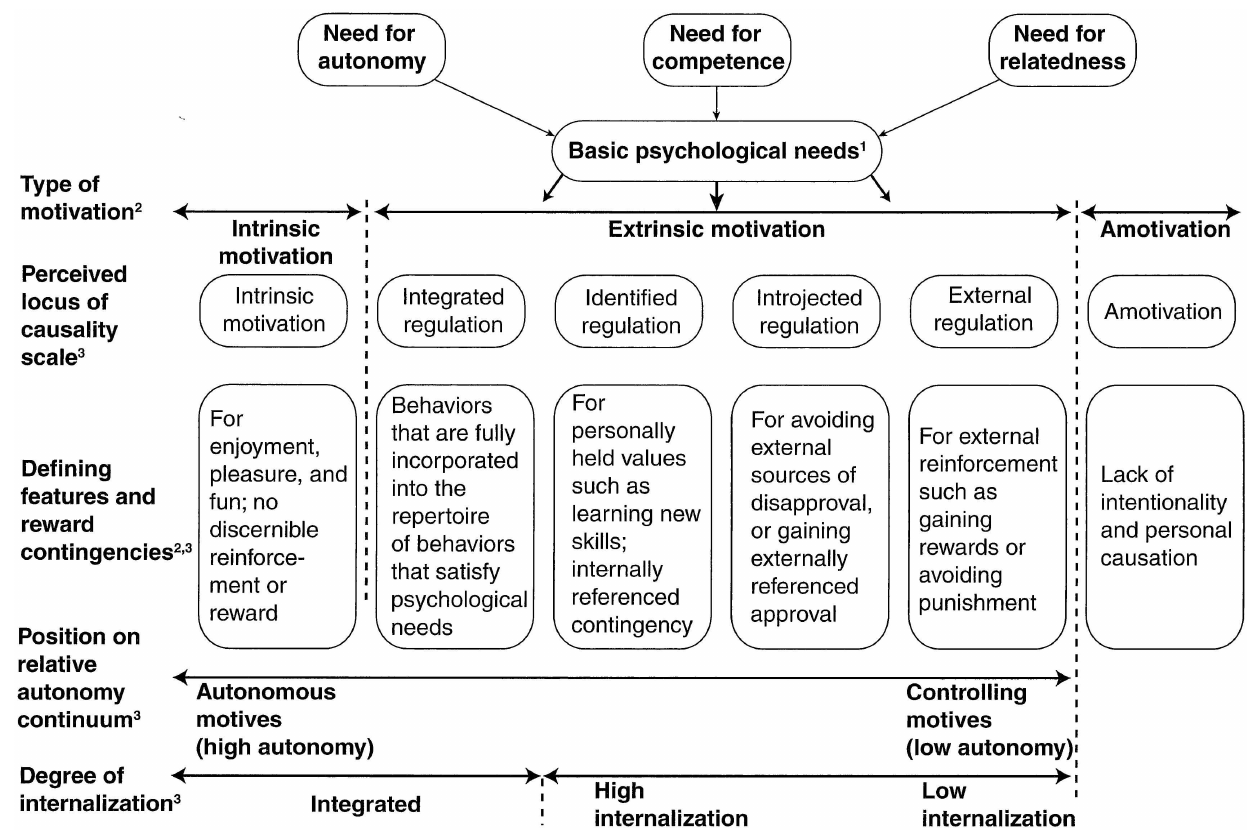
FIGURE 1 | Schematic representation of self-determination theory illustrating the features of three of the component subtheories: basic psychological needs theory, cognitive evaluation theory, and organismic integration theory. ©Martin S. Hagger. Reprinted, with permission, from R.M. Ryan and E.L. Deci, 2007, Active human nature: Self-determination theory and the promotion and maintenance of sport, exercise, and health. In Intrinsic motivation and self-determination in exercise and sport, edited by M.S. Hagger and N.L.D. Chatzisarantis (Champaign, IL: Human Kinetics), 8.